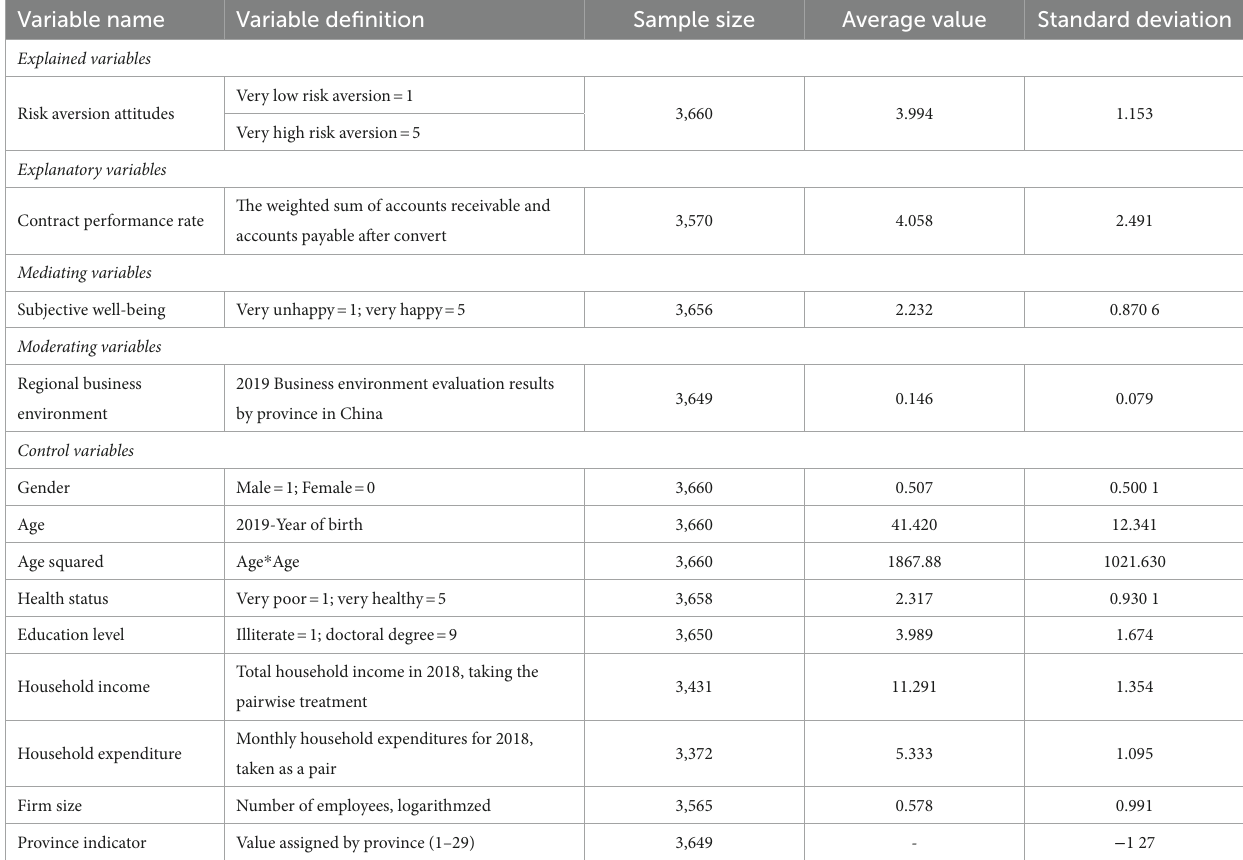
TABLE 3 Descriptive statistics of the main